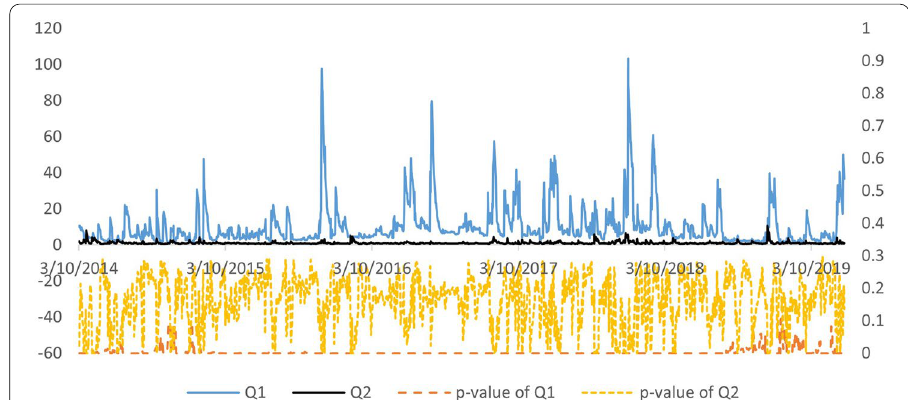
Fig. 3 Time-varying Granger test between GSVI and Returns (Q1: returns—> GSVI; Q2: GSVI- > returns). Note: The thick solid line is the Q1 test and the thin solid line is the Q2 test (the left axis). p-values of Q1 and Q2 are on the right axis. This likewise applies to Figs. 4, 5, 6, 7, 8